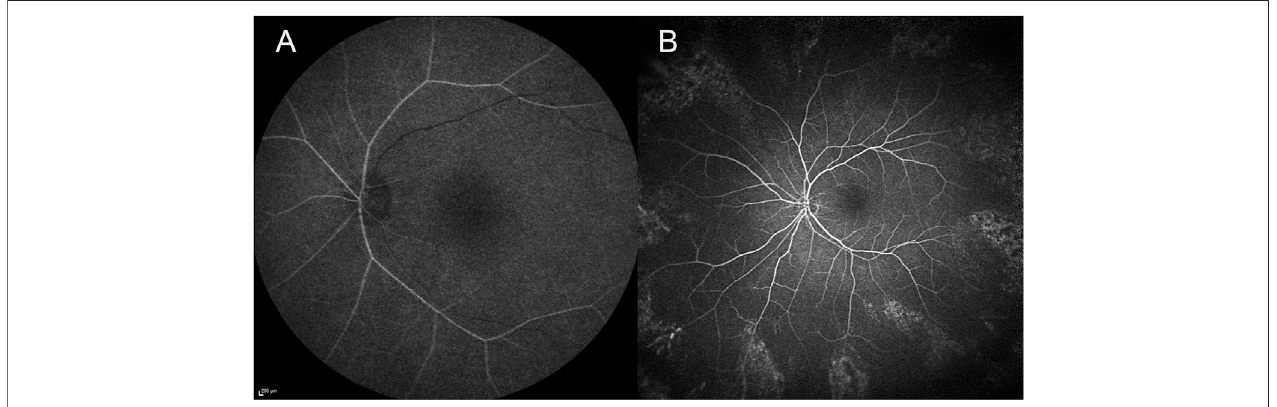
FIGURE 2 | Fluoresceinangiographyofthelefteye5 daysafterthediagnosisofCRAOshowingadelayedarrivalofthedyeintheeye43 saftertheinjection (A) ,peripheral areas of capillary nonperfusion, arteriovenous anastomoses, and neovascular ‘ sea-fans ’ 4 min and 22 s after the dye injection (B) [CRAO, central retinal artery occlusion].